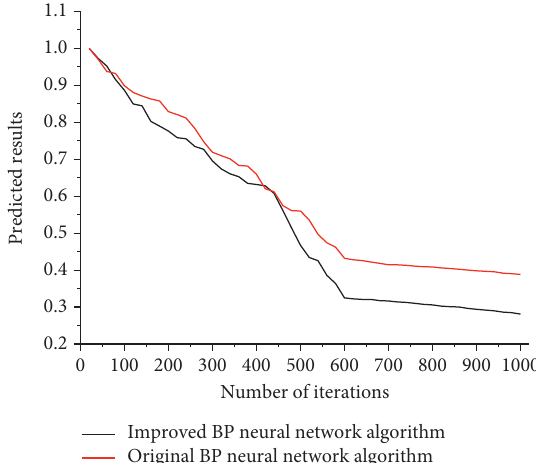
Figure 5: Comparison of the improved BP and the original BP prediction effect.